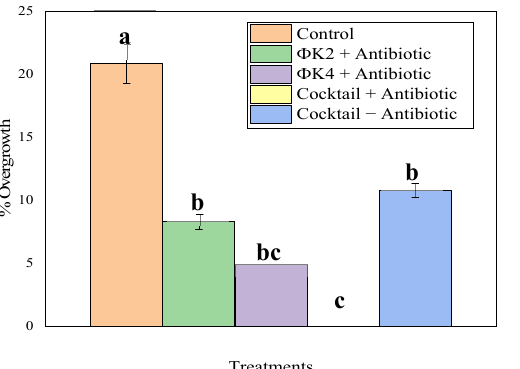
Figure 6. Percentage overgrowth of A. tumefaciens on callus. Results are presented as mean values ± SD. The same letters indicate no significant difference between treatments according to the Tukey HSD test at the level of α = 0.05.